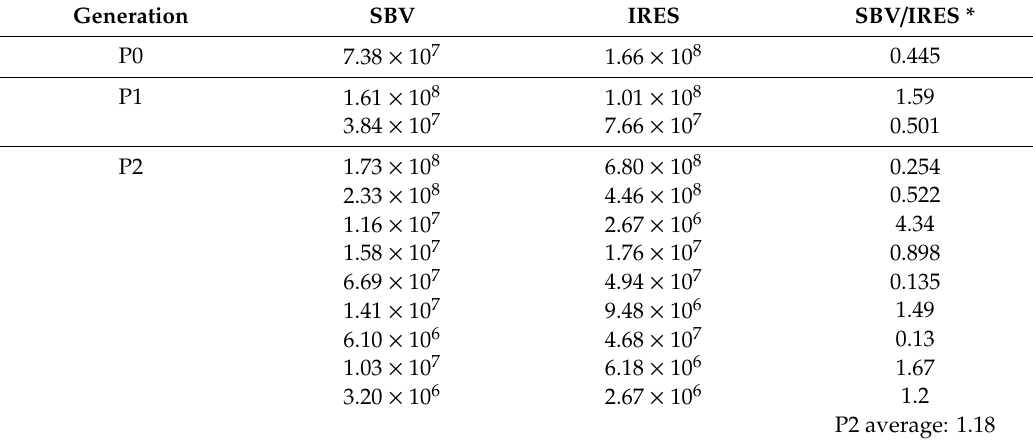
Table 1. Absolute qPCR results. The quantifications were conducted using transcribed cloned viral RNA as standards. Two primer sets, one specifically designed for the cloned SBV genome and the other designed for the added IRES fragment, were used for the same cDNA sample, and the results were divided to show if the added fragment remained in the 1:1 ratio with the SBV genome. The numbers in the table indicate the virus quantities in 1 µ L cDNA used for RT-qPCR; only the mean numbers of repeats were shown